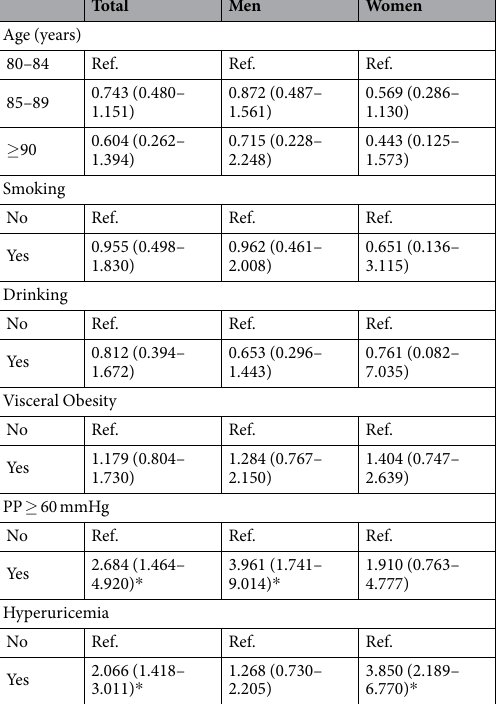
of SBP is already as high as 146 mmHg, while levels of DBP and PP are almost the same, which is a apparent char- acteristic in very elderly. Also, the mean levels of glucose, UA, and creatinine are relatively high in very elderly. According to NHANES study, the prevalence of total DM increases sharply with age, from 2.4% in population